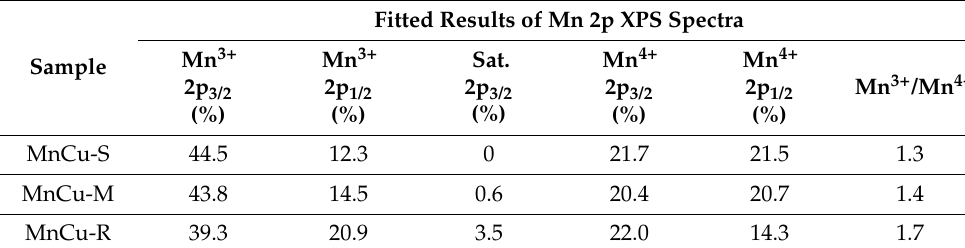
Table 5. Fitted Mn 2p XPS spectra results of MnCu-R, MnCu-M, and MnCu-S.